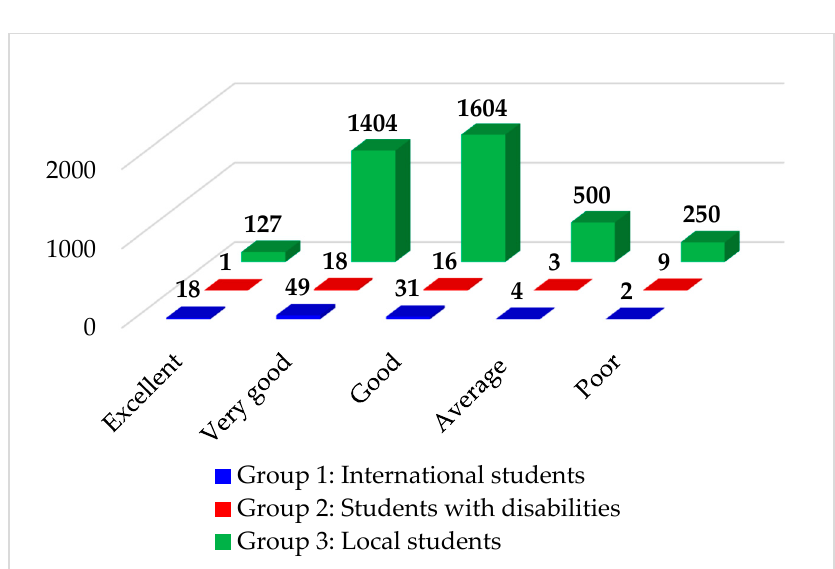
Figure 4. Numbers of samples in each group in Case 1: Origin.